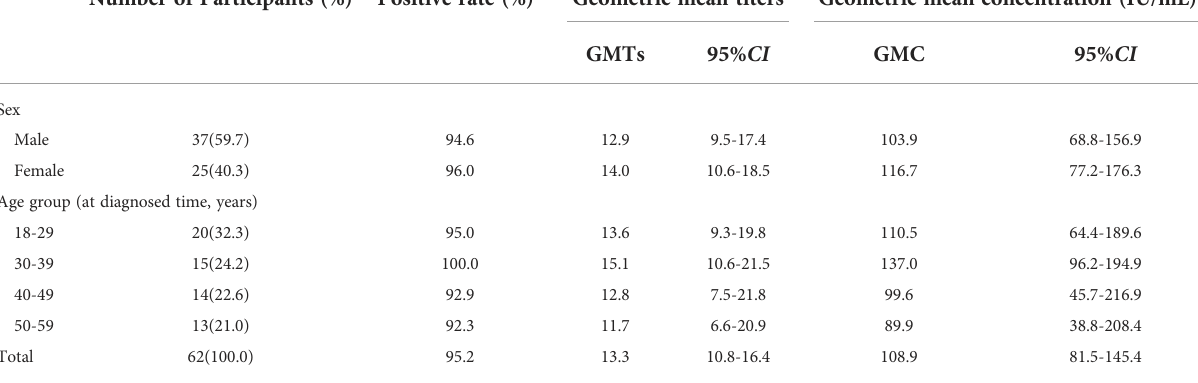
TABLE 2 Participant characteristics and nAb responses to COVID-19 convalescent sera obtained 6 months after diagnosis. Number of Participants (%) Positive rate